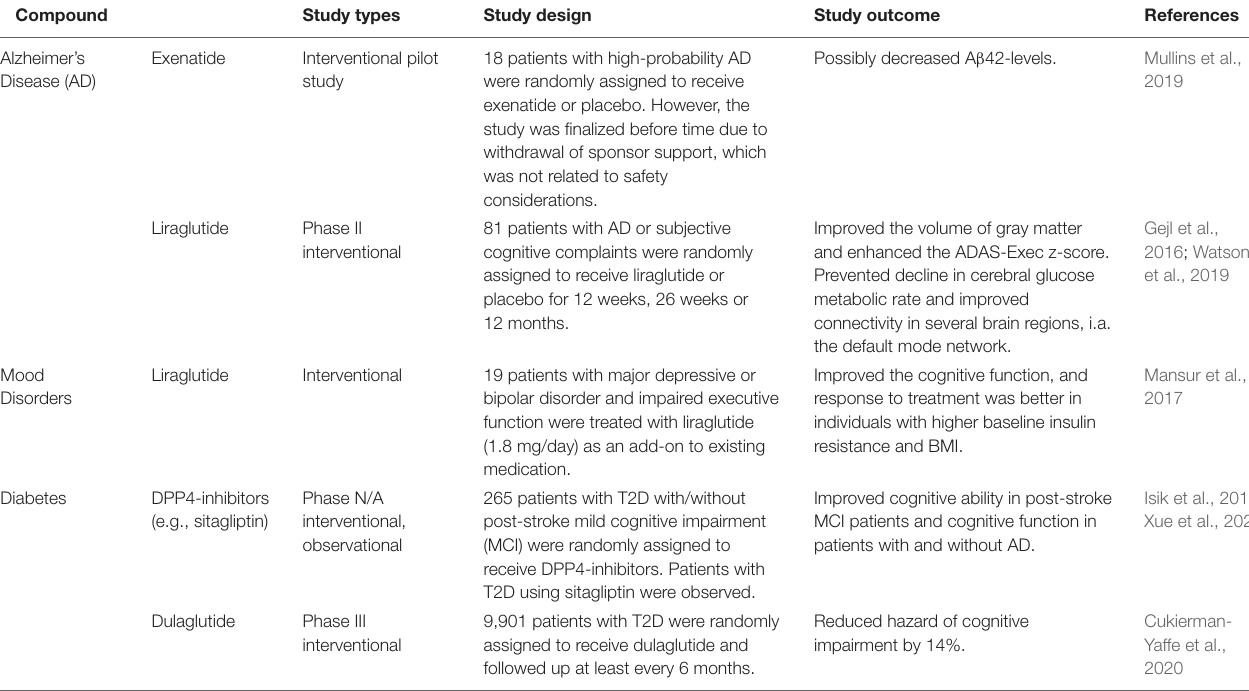
TABLE 5 | Clinical studies elucidating the use of GLP-1R agonists in Alzheimer’s disease and cognitive dysfunction in other